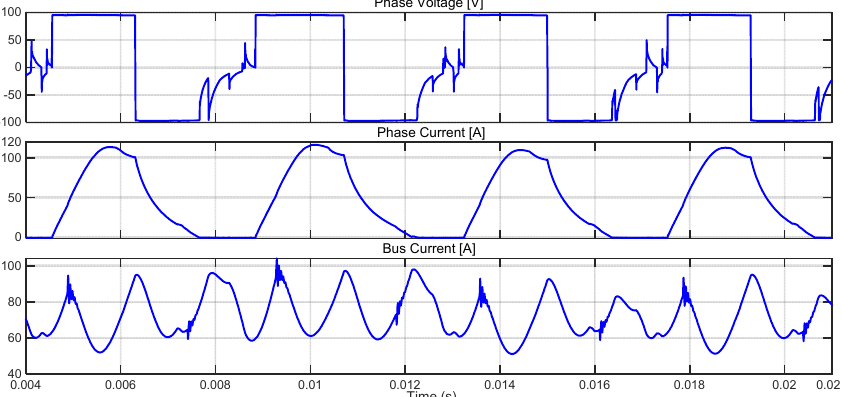
Figure 21. Experimental waveforms of phase current, phase voltage and bus current for 1400 rpm, 20 Nm with single pulse control θ ON = − 7°, θ OFF = 8°.